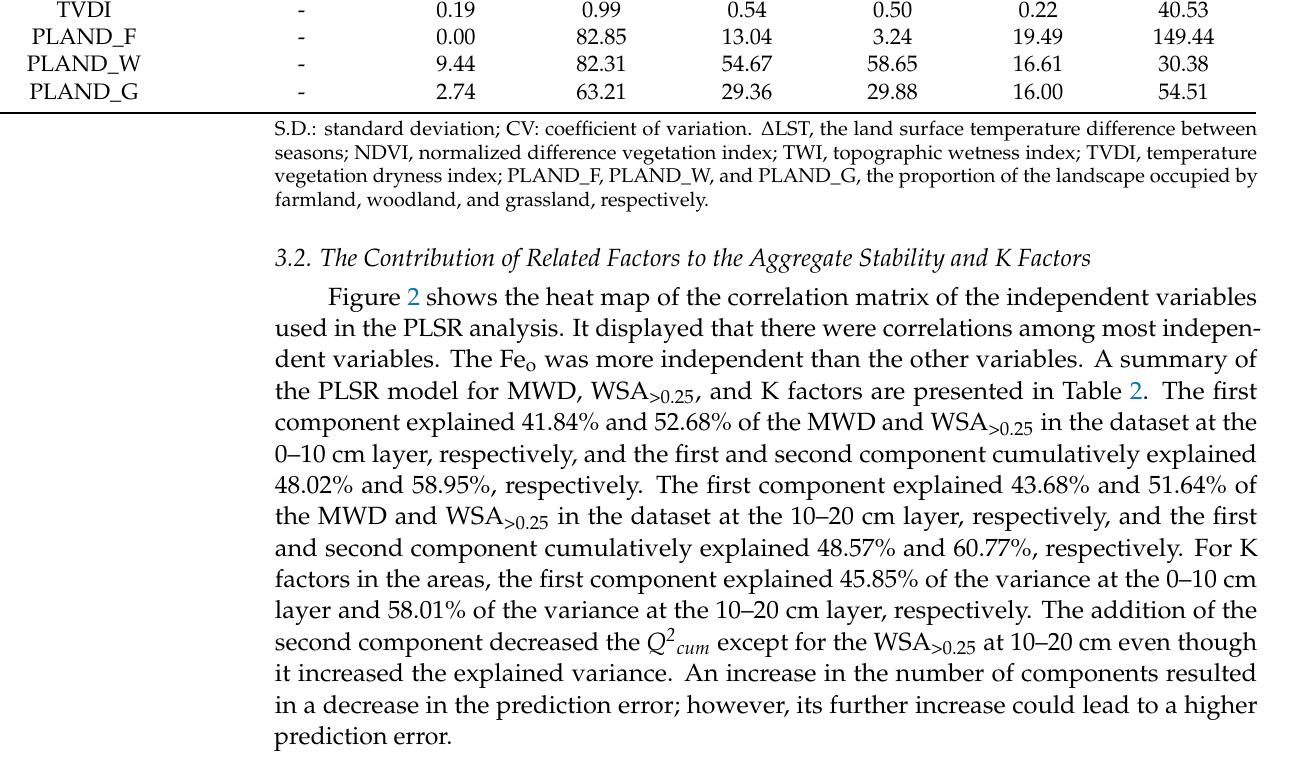
Table 2. Summary of the partial least-squares regression model for mean weight diameter (MWD), percentage of water-stable aggregates greater than 0.25 mm (WSA >0.25 ), and K factors in the